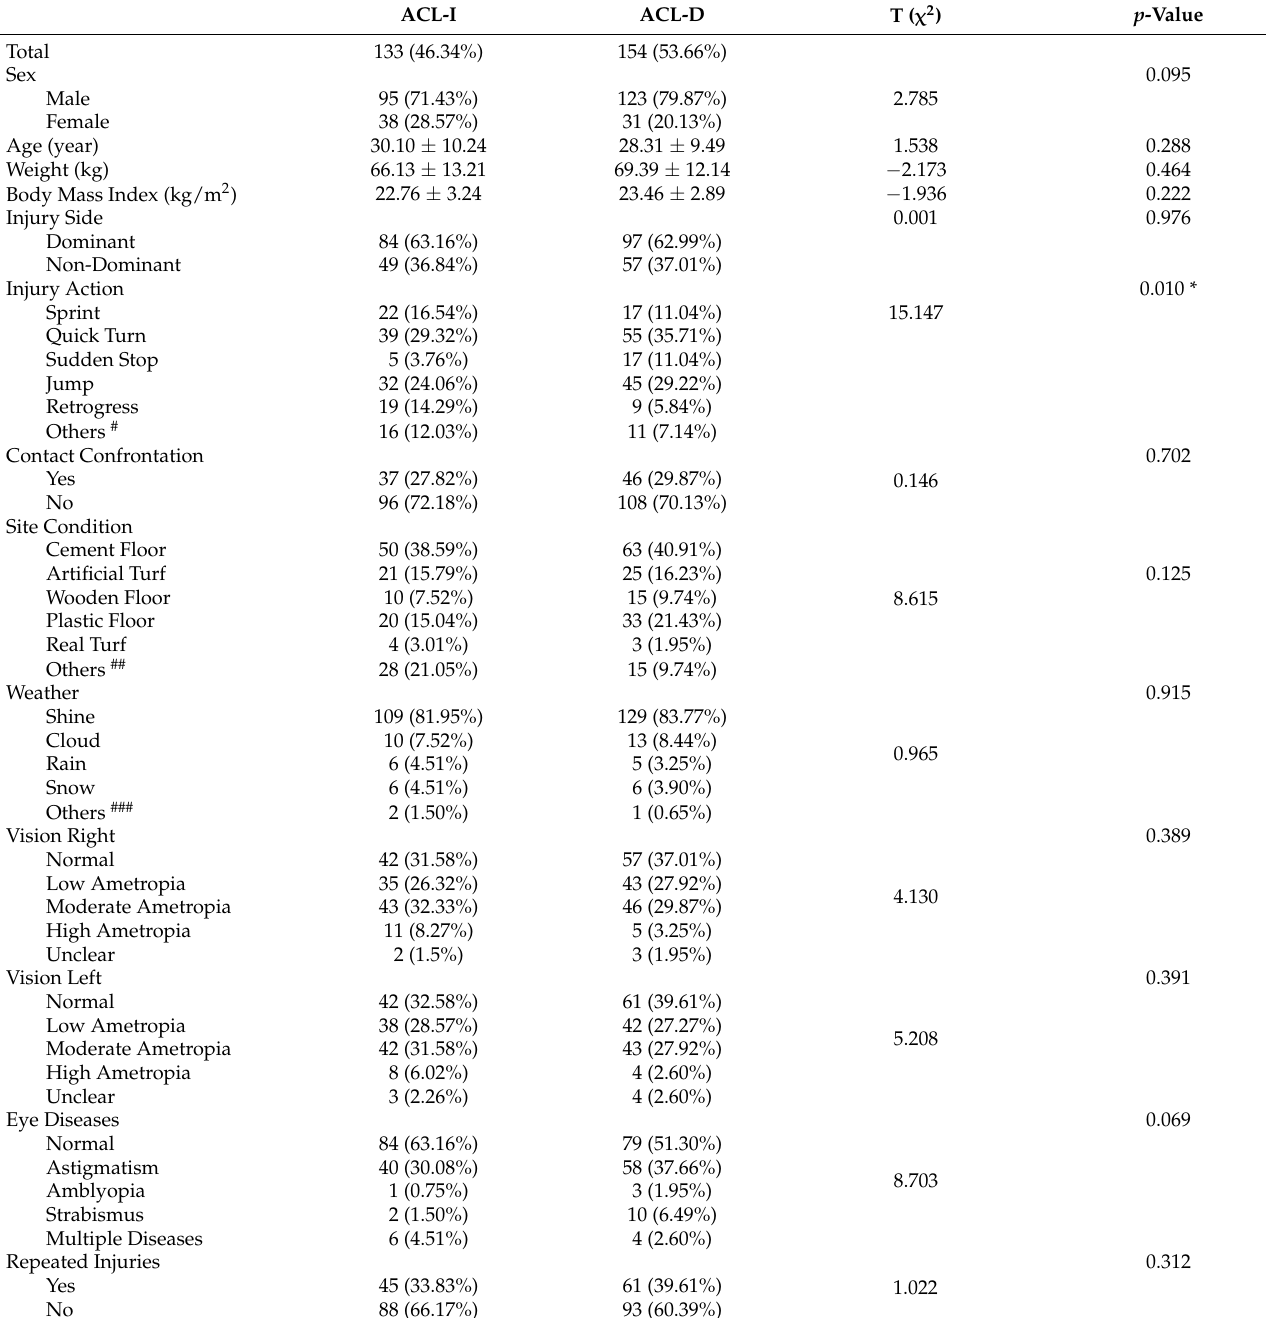
Table 1. Statistical description of 287 knee injury